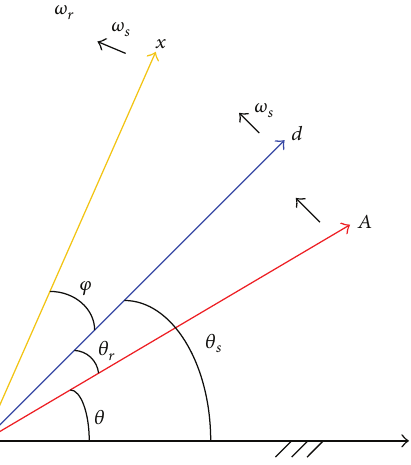
Figure 2: Convolution vector